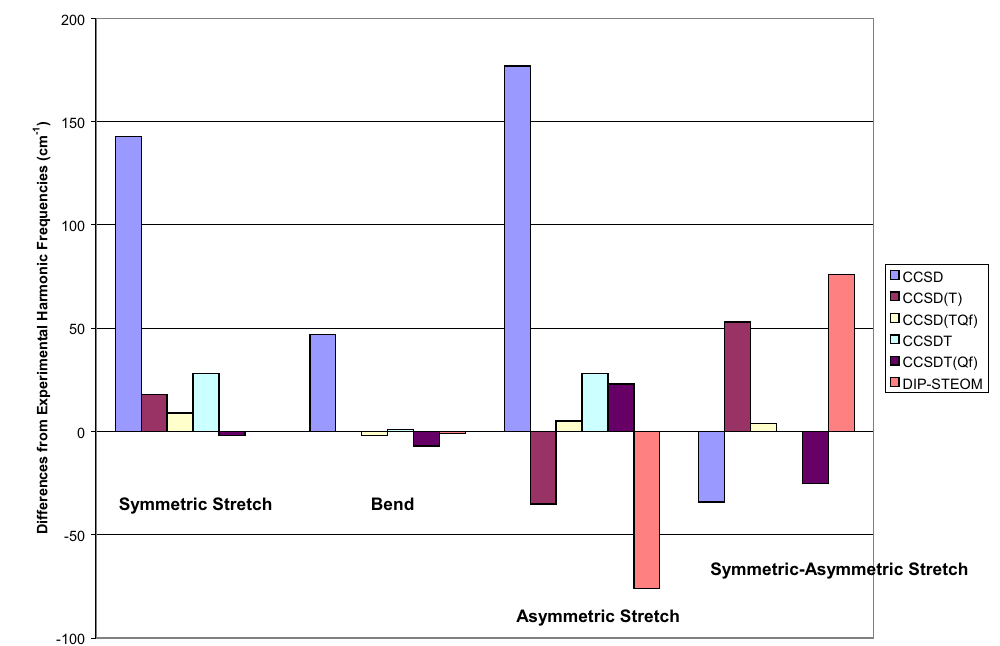
Figure 6: Vibrational frequencies of ozone for various methods within a cc-pVTZ